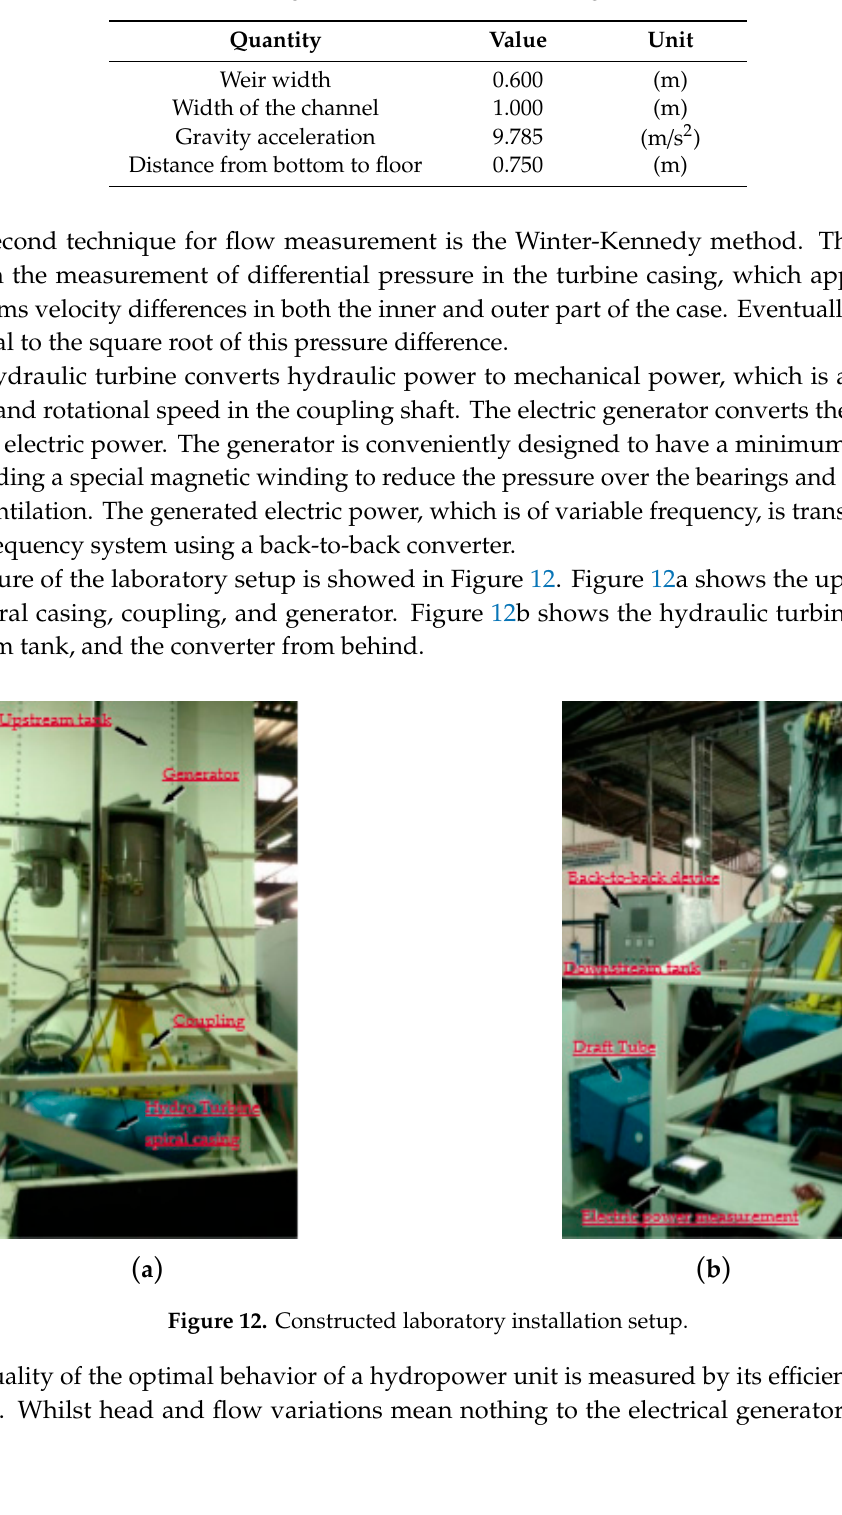
Table 2. Design characteristics of the rectangular weir.